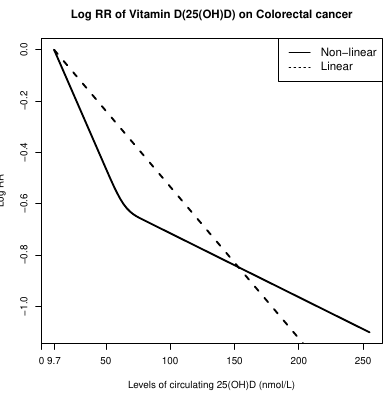
Figure 2. Log colorectal cancer RR for levels of circulating 25(OH)D compared to the reference level, 9.734 nmol/L, based on the full calibration